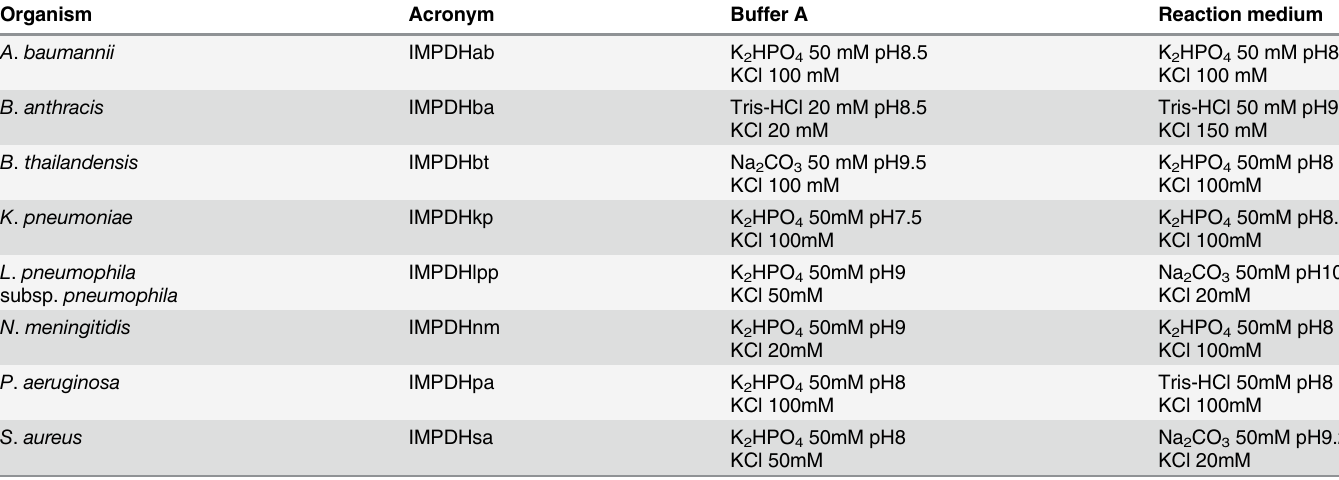
Table 2. Composition of buffers used for puri fi cation and enzymatic assay (buffer A and reaction medium, respectively) for each IMPDH (named by an acronym).